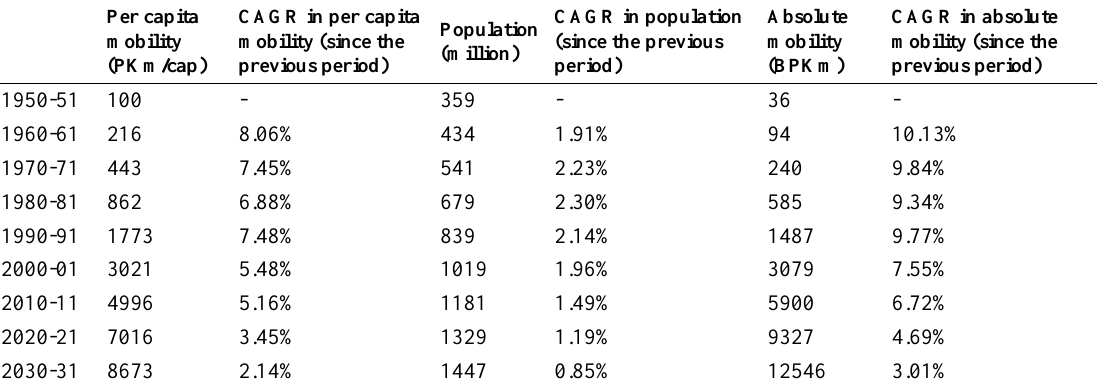
Table 3. Level as well as growth of road-based passenger mobility in India from 1950-51 to